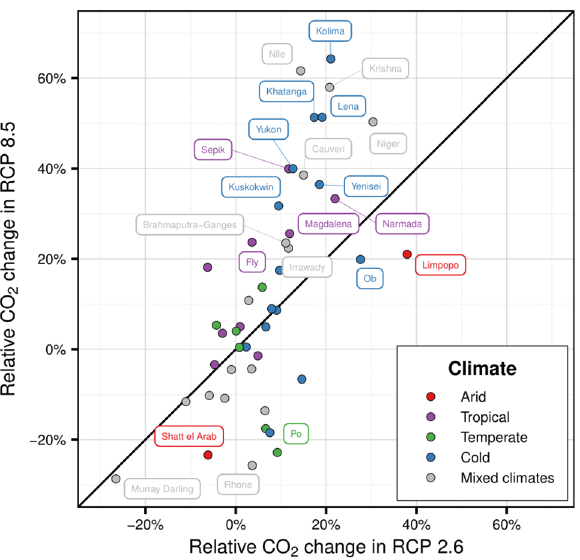
Figure 3. Comparison of the relative CO 2 uptake change in the river basins used for MEGA 21 model validation for both climatic scenarios. Only river basins showing a relative change over ± 20% are labelled. The straight black line represents equal